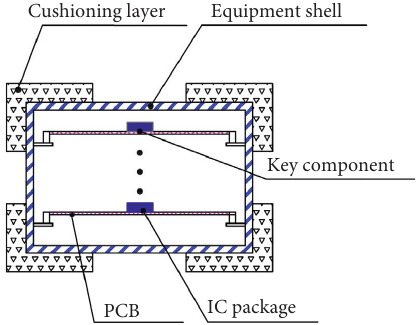
Figure 1: Sketch of a packaging system including a key